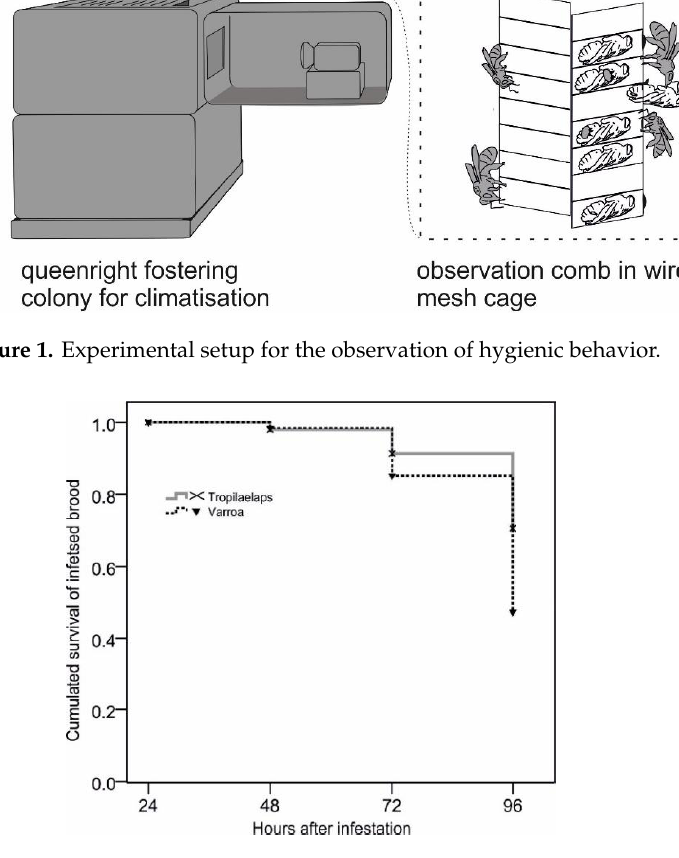
n.a. Figure 3. Intensity of cell opening behavior towards V. destructor - and T. mercedesae -infested brood. 3.3. Comparison of Tropilaelaps Removal by A. mellifera, A. cerana, and Mixed-Species Groups of Worker Bees Here, “survival” means that brood was not opened and removed by the worker bees. The graph is based on a total of 1228 artificially infested cells. The period of 0–24 h post-infestation is not displayed, because combs were placed inside a non-hygienic hive for repair of manipulated cell caps by the bees. The time course of brood survival differed significantly between treatments (χ 2 = 26.8; p < 0.001). Figure 4 compares the cumulated survival over time of Tropilaelaps -infested cells in the treatments mbees_mbrood, cbees_cbrood, and xbees_xbrood. It can be seen that A. cerana bees, when observed on their own brood and in the absence of A. mellifera workers, showed the fastest removal of infested brood, and also removed the greatest proportion of it. This difference was significant for the comparisons with mbees_mbrood, as well as with xbees_cbrood (χ 2 = 20.7 and 7.3; p <0.001 and 0.007), while it was marginally non-significant in the case of xbees_mbrood (χ 2 = 3.2; p = 0.075). The three sets of experiments in which mellifera workers were used, either alone or in combination with A. cerana , formed a homogeneous block (χ 2 = 2.3–3.8; p = 0.127–0.053), indicating that the presence or absence of A. cerana workers did not influence hygienic behavior in these experiments. A. cerana and A. mellifera did not differ with regard to the median duration of uninterrupted cell opening events, although the range of durations was far wider in A. cerana (total n = 167; A. cerana : median = 104 s (7 to 5569); A. mellifera : median = 94 s (1 to 630)). The intensity of initiations of cell openings was generally quite similar in all treatments, but judged slightly lower in the case of xbees_cbrood than